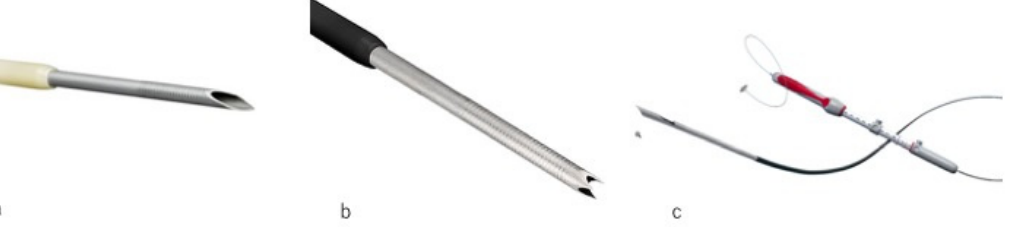
Figure 6. EUS-guided fine needle aspiration (EUS-FNA) and EUS-FNB needles. ( a ) EUS-FNA needle (Lancet needle (Expect Endoscopic Ultrasound Aspiration Needle; Boston Scientific Corp, Natick, MA, USA)). ( b ) EUS-FNB needle (Franseen-like needle (Acquire; Boston Scientific Corp, Natick, MA, USA)). ( c ) EUS-FNB needle (Side-fenestrated needles (ProCore; Cook Medical, Bloomington, IN, USA)).